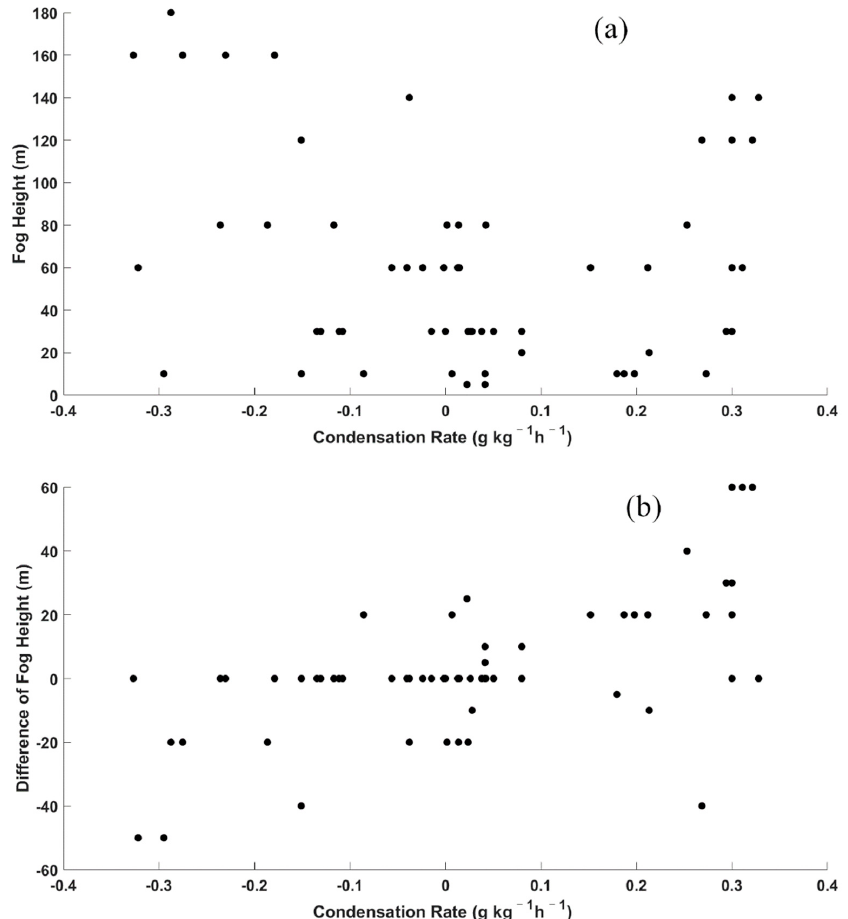
Figure 2. ( a ) Scatterplots of observations of fog-top height against the condensation rate. ( b ) Scatterplots of observations of the difference of fog-top height against the condensation rate. Previous studies show that the fog-top height is influenced by the buoyancy generated by radiative cooling at the fog top, other than the turbulence. Therefore, sensible flux was chosen as the scaling parameter to represent the intensity of buoyancy and used to estimate the fog-top height. Compared with the estimations with turbulence intensity, the relationship between the fog-top height and sensible flux is complicated, and the scatter points are discrete, especially when the values of sensible flux are near zero (not shown here). It is obvious that the relationship between the fog-top height and sensible flux can be divided into two phases: the positive and negative sensible flux. Therefore, the relationship between the fog-top heights and absolute values of sensible flux is developed, and Equation (13) is obtained, with a coefficient of determination of R 2 = 0.40 (Figure 3a): H = 29.49 ×| H c| 0.45 (13) Though the result indicates that the absolute values of sensible flux can be as a potential indicator of the fog-top height, there are some discrepancies between estimations and observations, especially for low sensible flux. The results are similar to the results in Román-Cascón et al. [33], with significantly dispersed distribution and larger error bars. Therefore, sensible flux may be not the appropriate indicator to represent the buoyancy and other described parameters should be sought out to represent the buoyancy induced by radiative cooling.